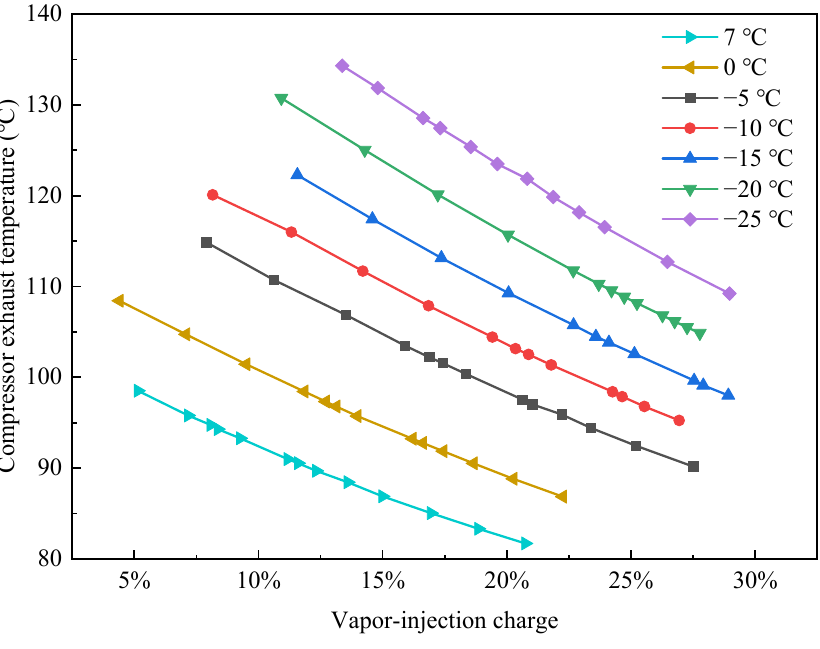
Figure 9. Effect of vapor-injection charge on exhaust temperature.